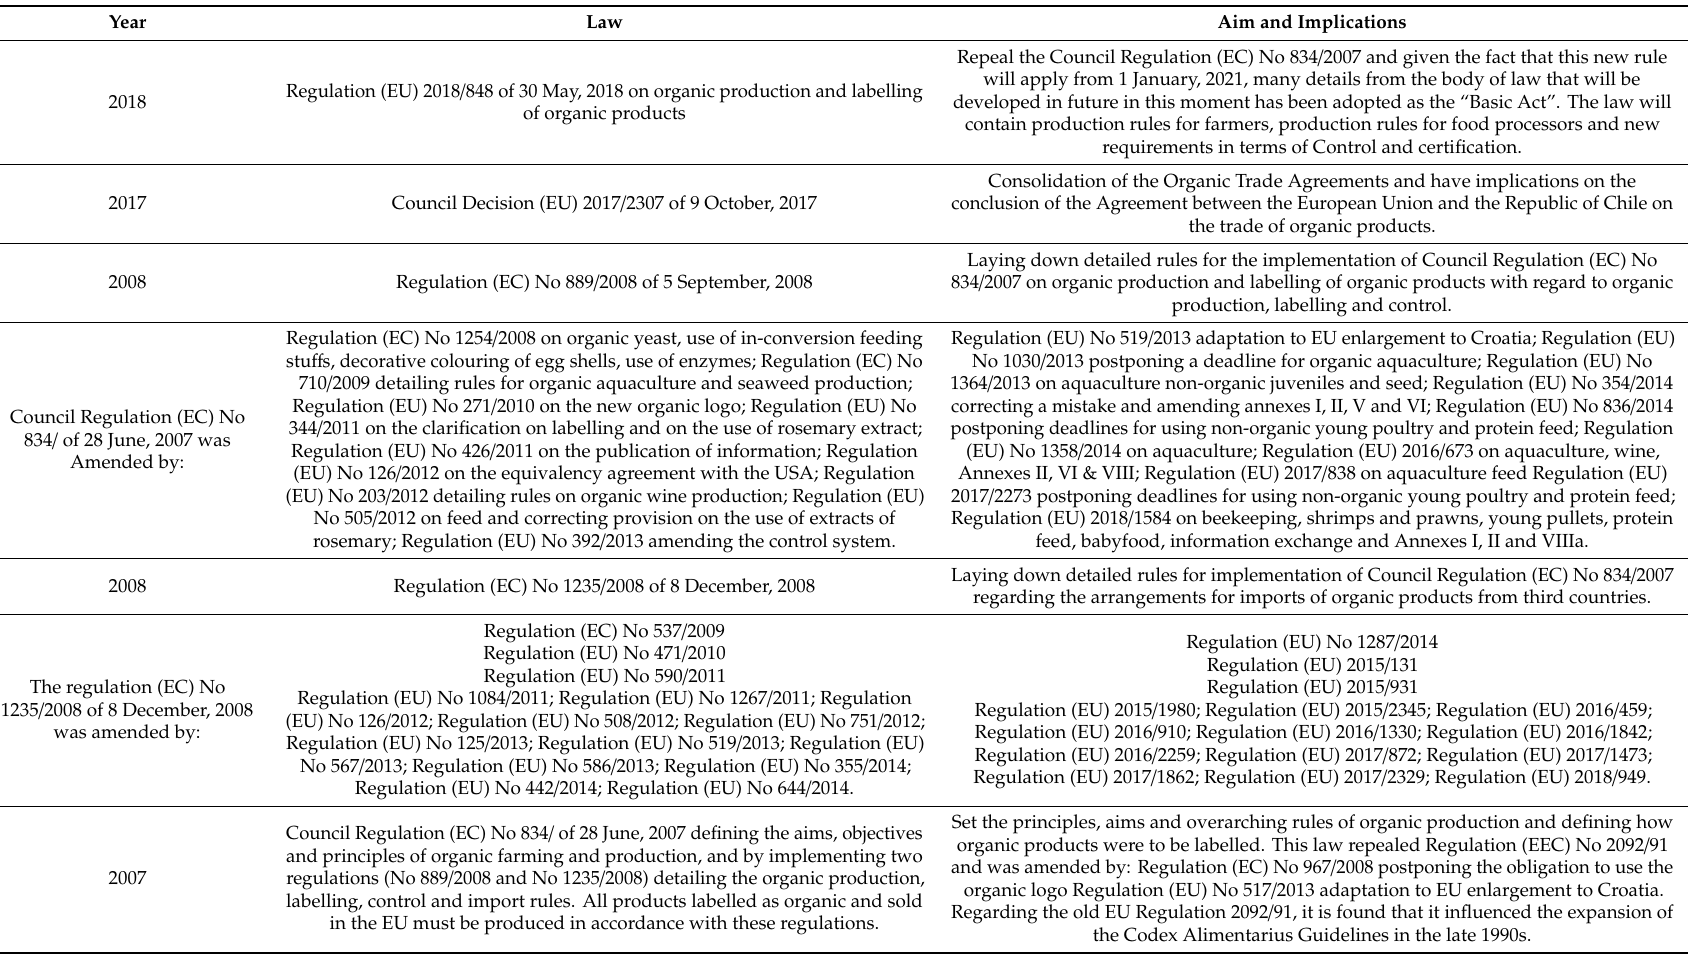
Table 1. EU organic regulations